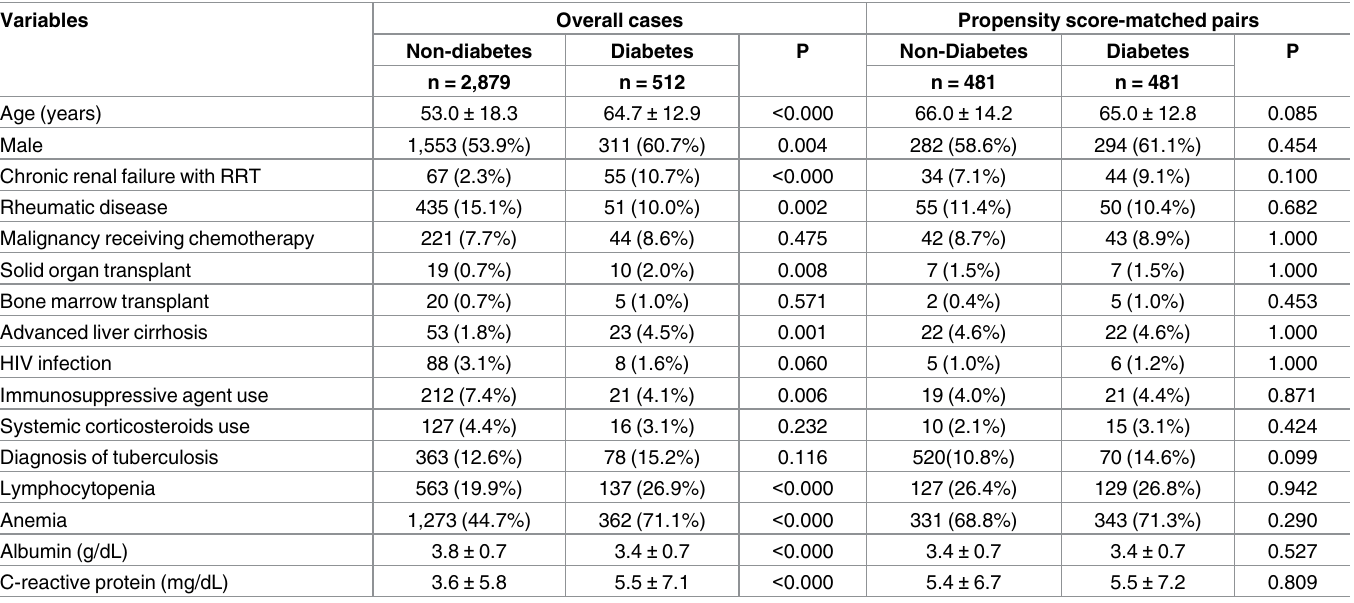
Table 3. Patient characteristics before and after propensity score